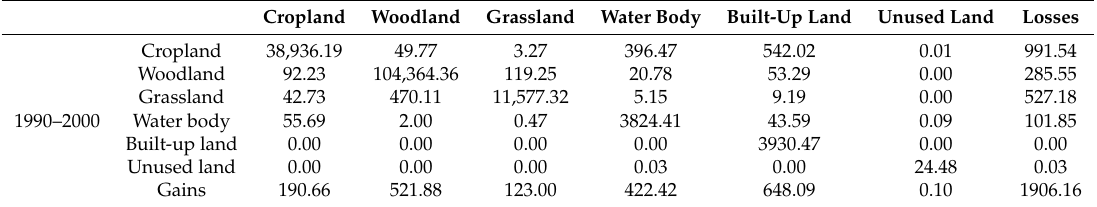
Table 2. The land-use and land-cover change (LUCC) matrix in the Zhujiang–Xijiang Economic Belt (ZXEB) from 1990 to 2000 (unit: km 2 ).